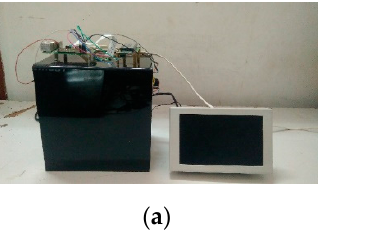
( b ) Figure 13. Software implementation system for the leaf: ( a ) Grade 1 and ( b ) grade 5. 4.2. Leaf Features Area and perimeter of each leaf were obtained from both manual and the image processing method. The data are shown in Table 5. Mean values of area and perimeter from 1500 leaves are given for both manual and image processing. The absolute difference between image processing and the manual method results is stated as error (%). The extent of data to give information about data distribution is defined by standard deviation (SD). The maximum error in area was 2.76 cm 2 for grade 3. However, in percentage, grade 1 gave the largest error in area at about 5.25%. The image processing method to calculate area best worked for grade 5, with only 1.43% error. On average, the error in area calculation was about 3.68% for the five grades. The opposite situation occurred in the perimeter feature, when the smallest error occurred in grade 1 at 5.20%. The average error for perimeter calculation using image processing in all grades was 1.74 cm or 5.98%. Table 5. Mean of area and perimeter for five grades. Grade